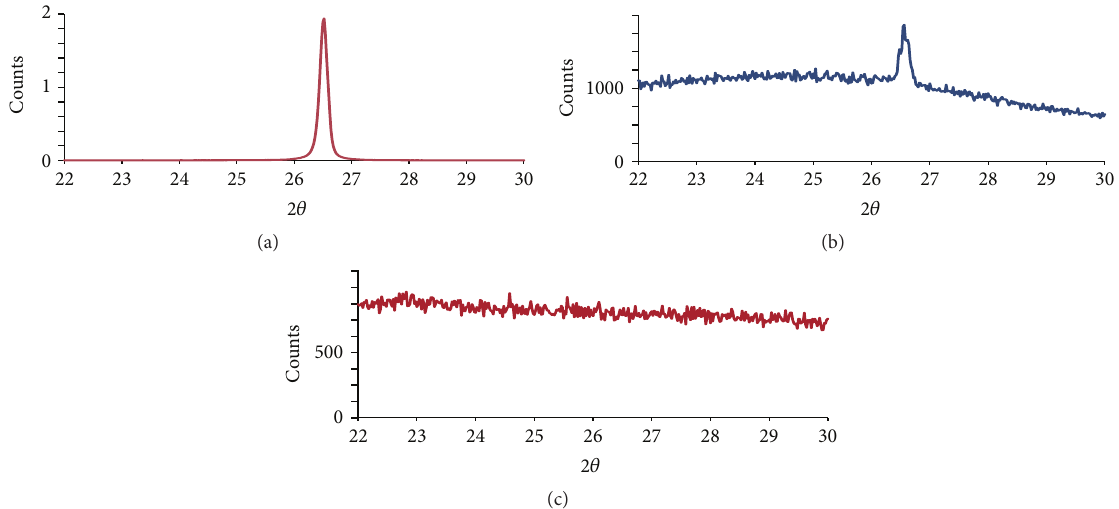
Figure 2: Powder X-ray diffraction patterns for graphite (a), commercial activated carbon (b), and amorphous carbon prepared in this work (c).